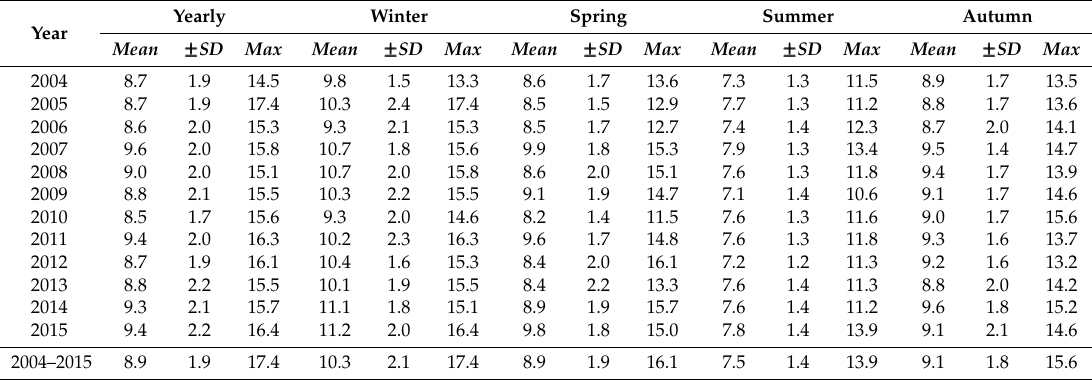
Table A6. Summary statistics from annual and seasonal analyses of T E (s) at BB.